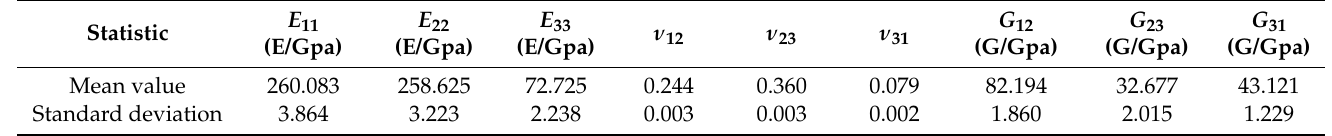
Table 11. Statistics of equivalent elastic parameters of 2.5D braided